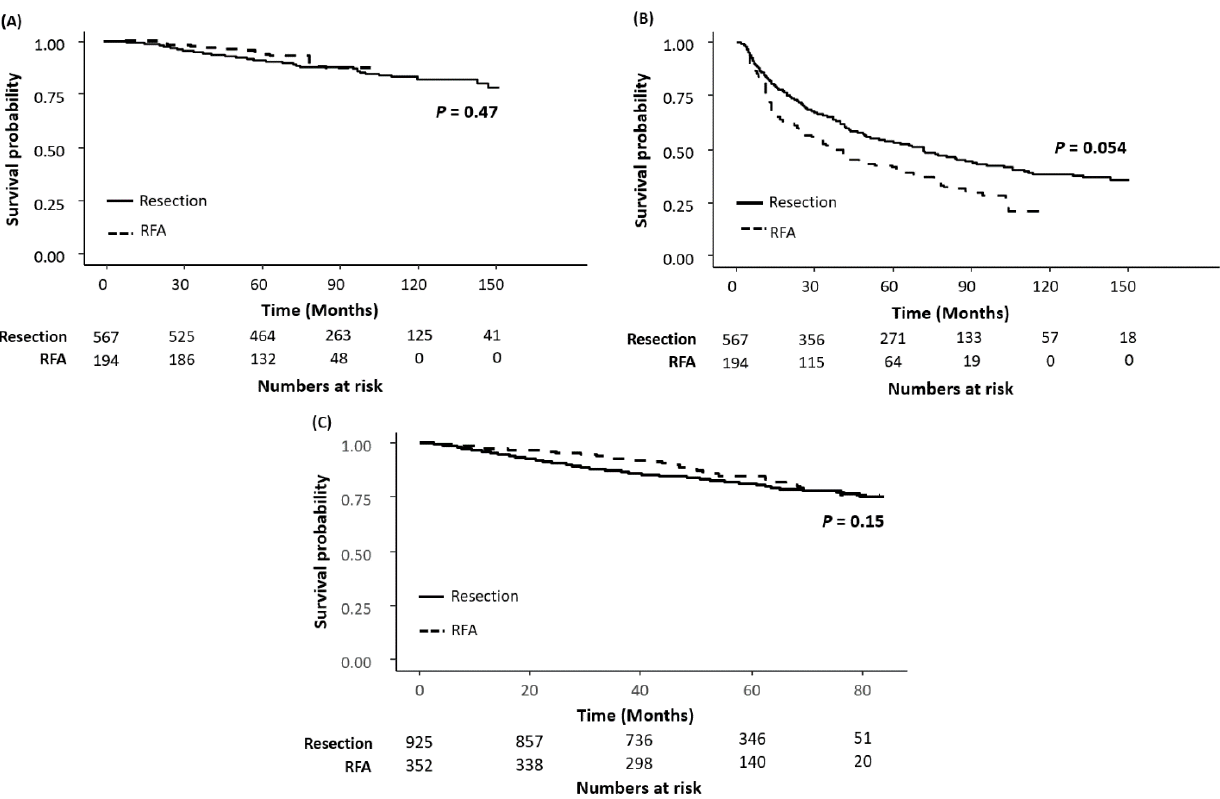
Figure 2. Kaplan–Meier estimates of ( A ) OS and ( B ) RFS in the hospital cohort, and ( C ) OS in the nationwide cohort after IPTW. OS or RFS was computed for all patients in the efficacy population. Patients who had not died by the date of data cut-off were censored in the case of OS estimation, and patients who had not experienced recurrence or died as of the date of data cut-off were censored in the case of RFS estimation.